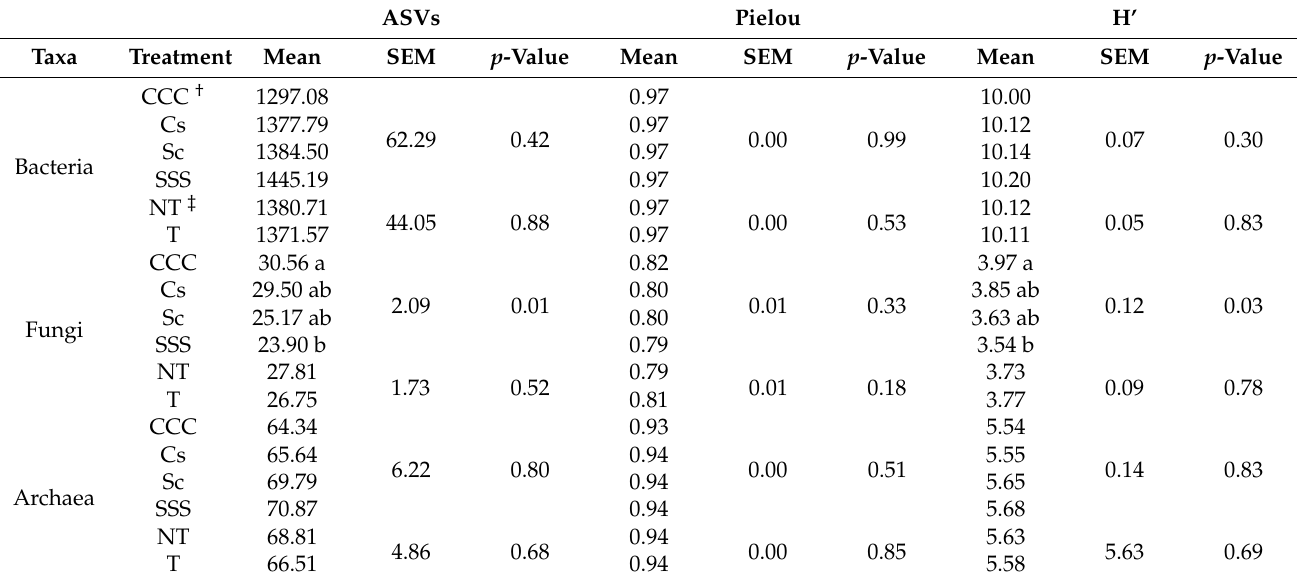
Table 1. Mean values and standard errors of the mean (SEM) for the α -diversity parameters of observed amplicon sequence variants (ASVs), Pielou Evenness Index (Pielou), and Shannon’s Diversity Index (H’) for bacteria, fungi, and archaea taxa, following 20 years of crop rotation and tillage treatments. For each taxon group and within a given column, treatment mean values followed by the same lowercase letter were not statistically different ( α = 0.05). ASVs Pielou H’